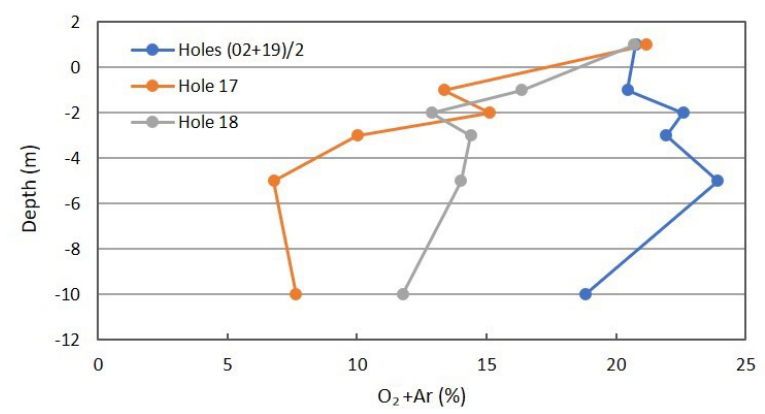
Figure 12. Oxygen+Ar profile for combined background locations and Locations 17 and 18 in Fault Zone 2. See Figure 5 for the locations.